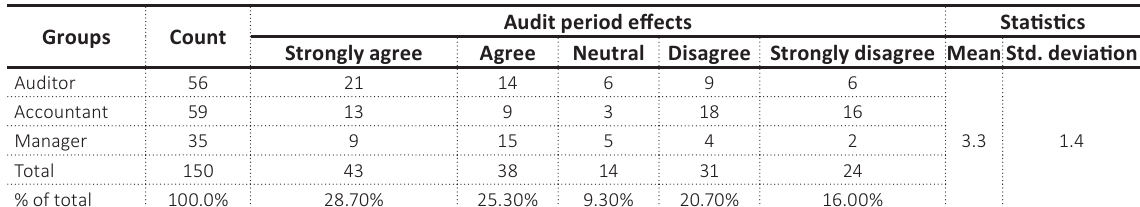
Table 3. Descriptive statistics on the influence of audit period on creative accounting